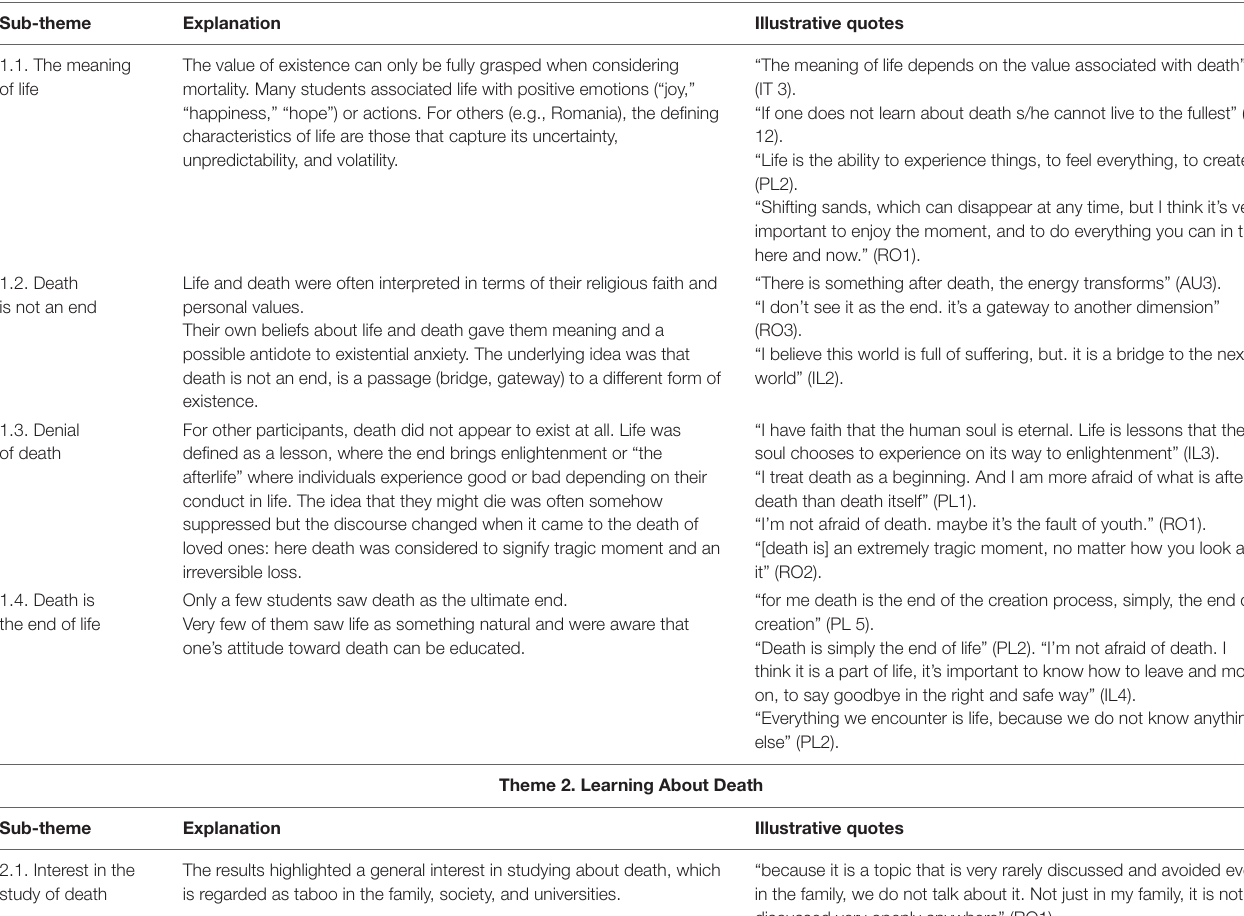
TABLE 4 | Themes from qualitative